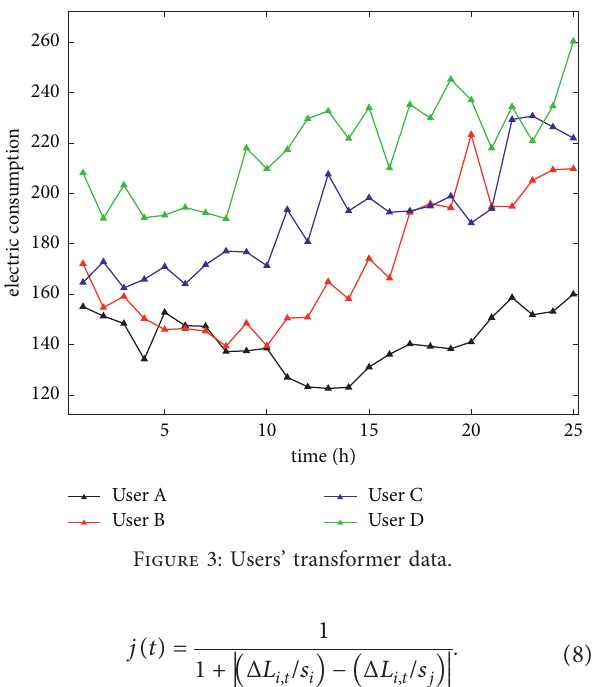
Figure 3: Users’ transformer